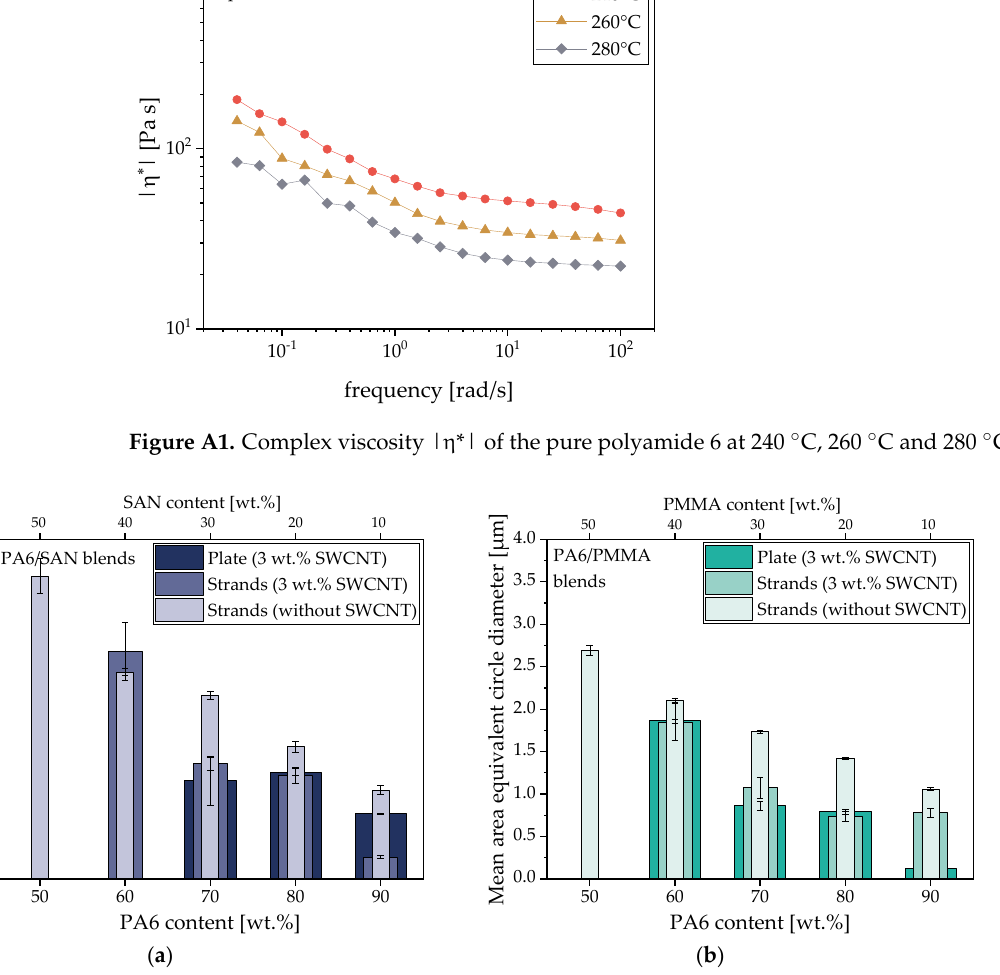
Figure A2. Mean area equivalent circle diameter of the dispersed (dissolved) components determined from SEM images shown in Figure 7 for PA6/SAN blends ( a ) and in Figure 8 and PA6/PMMA blends ( b ) such as strands without SWCNTs, strands with 3 wt.% SWCNTs, and compression-molded plates with 3 wt.% SWCNTs. Table A1. Surface tension values of the polymers and CNTs as taken from the literature. Material